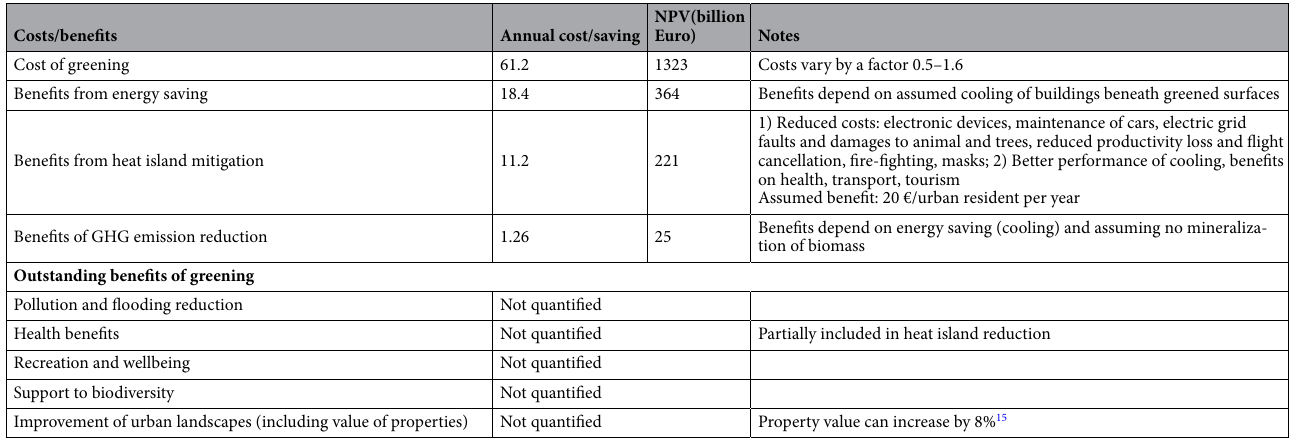
Table 2. Summary of benefits and costs of urban greening considered in this study for the European